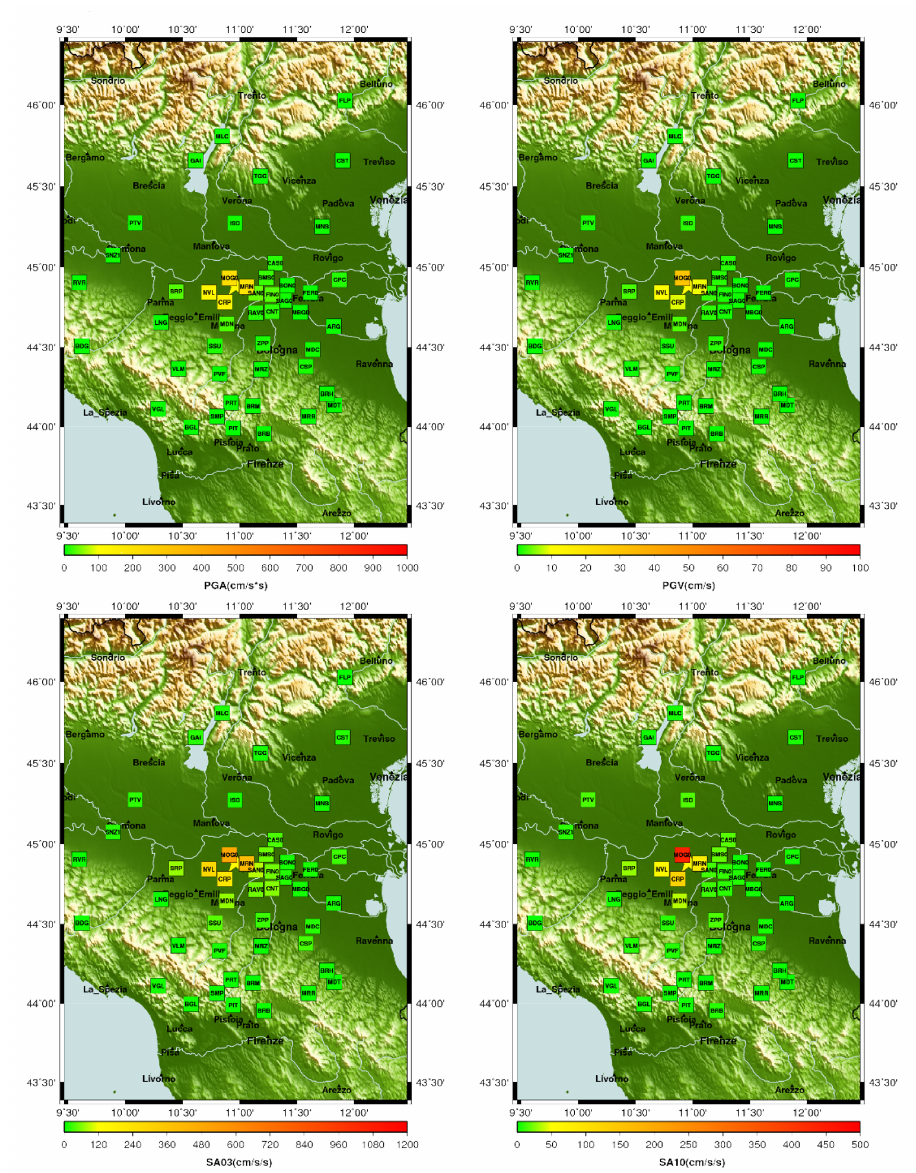
Figure 7. Examples of maps present in the report for the 29 May 2012 Emilia earthquake (Lat 44.886, Long 10.967, M l 5.3, M w 5.5, Seismic moment 3.92 × 10 17 Nm, Agency UniTS). In the upper left corner, the peak ground acceleration (PGA); in the upper right corner, the peak ground velocity (PGV); in the bottom left corner, the SA03; and in the bottom right corner, the